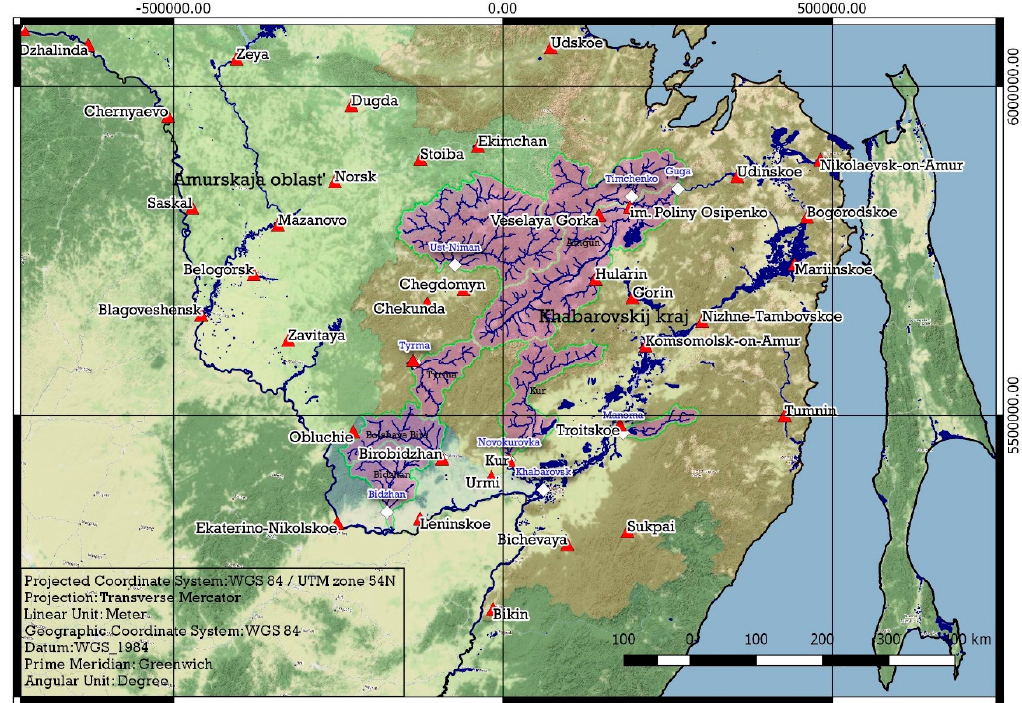
Figure 3. Location of river watersheds of the Middle and Lower Amur River basin (highlighted in purple). Meteorological stations are marked with red triangles, and stream gauges—in with white diamonds.